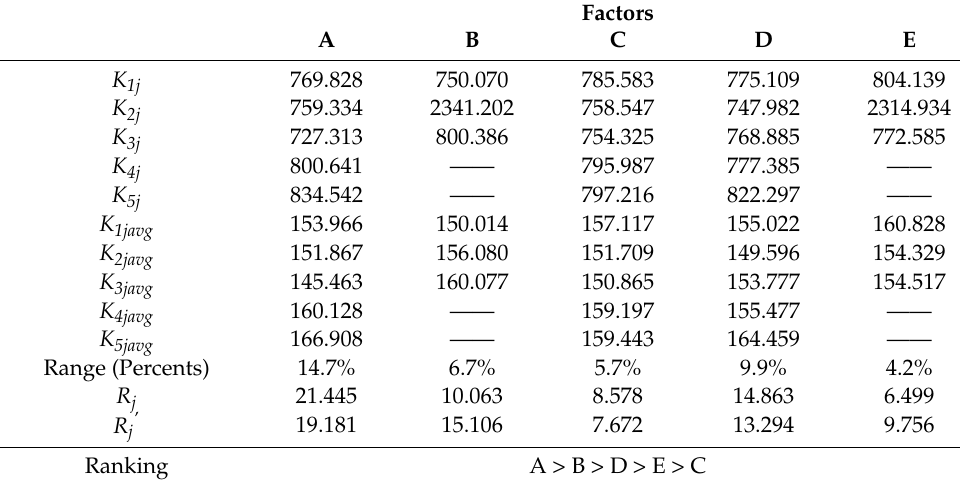
Table 4. The results of the range analysis of the